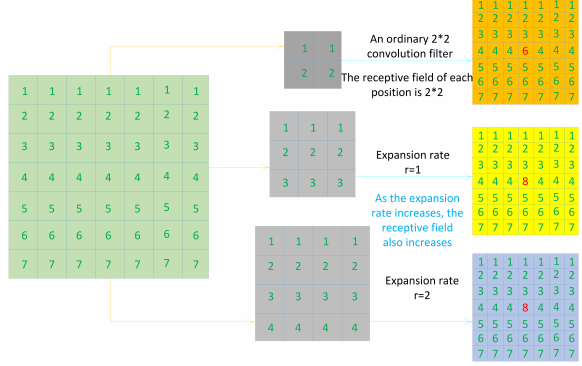
Fig. 2. Comparison of standard convolution and expanded convolution